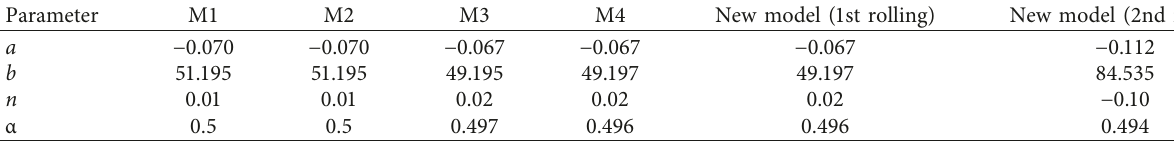
Table 5: Parameters of the five grey models.